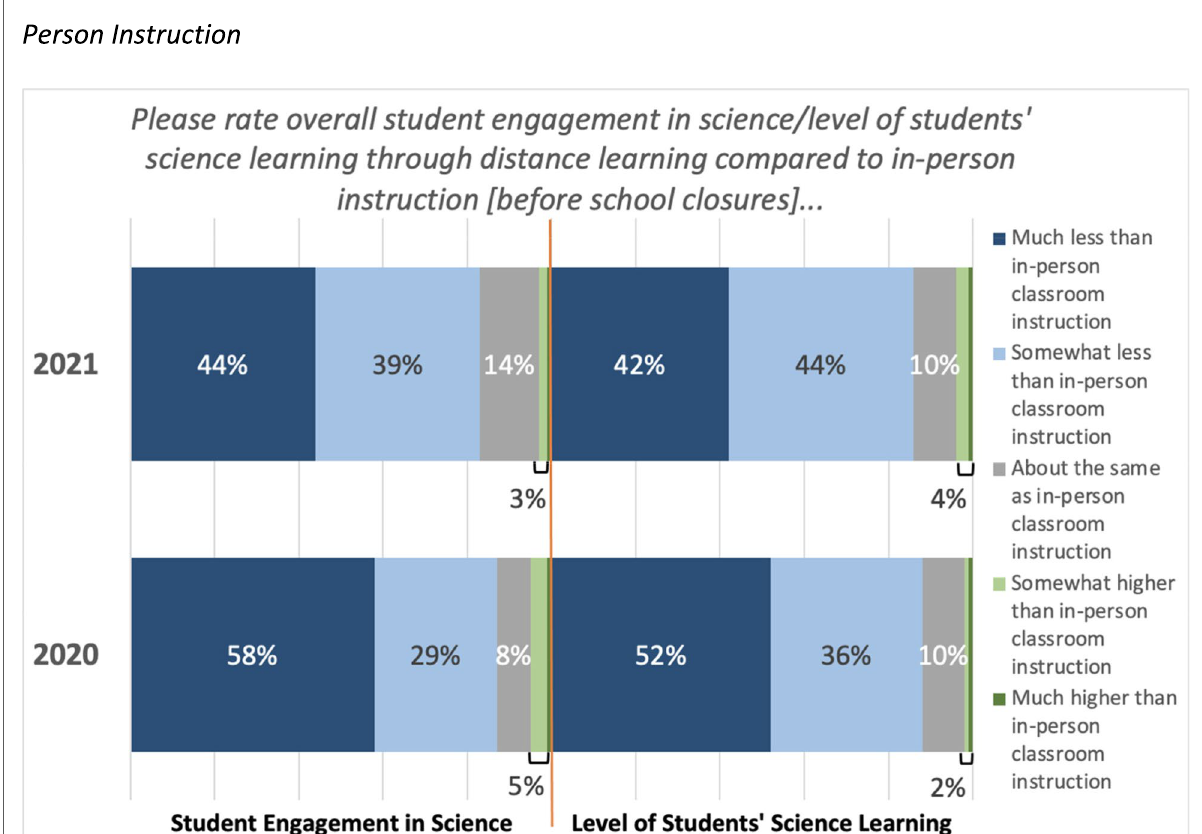
Fig. 1 Student Engagement and Level of Science Learning Through Distance Learning Compared to In-Person Instruction